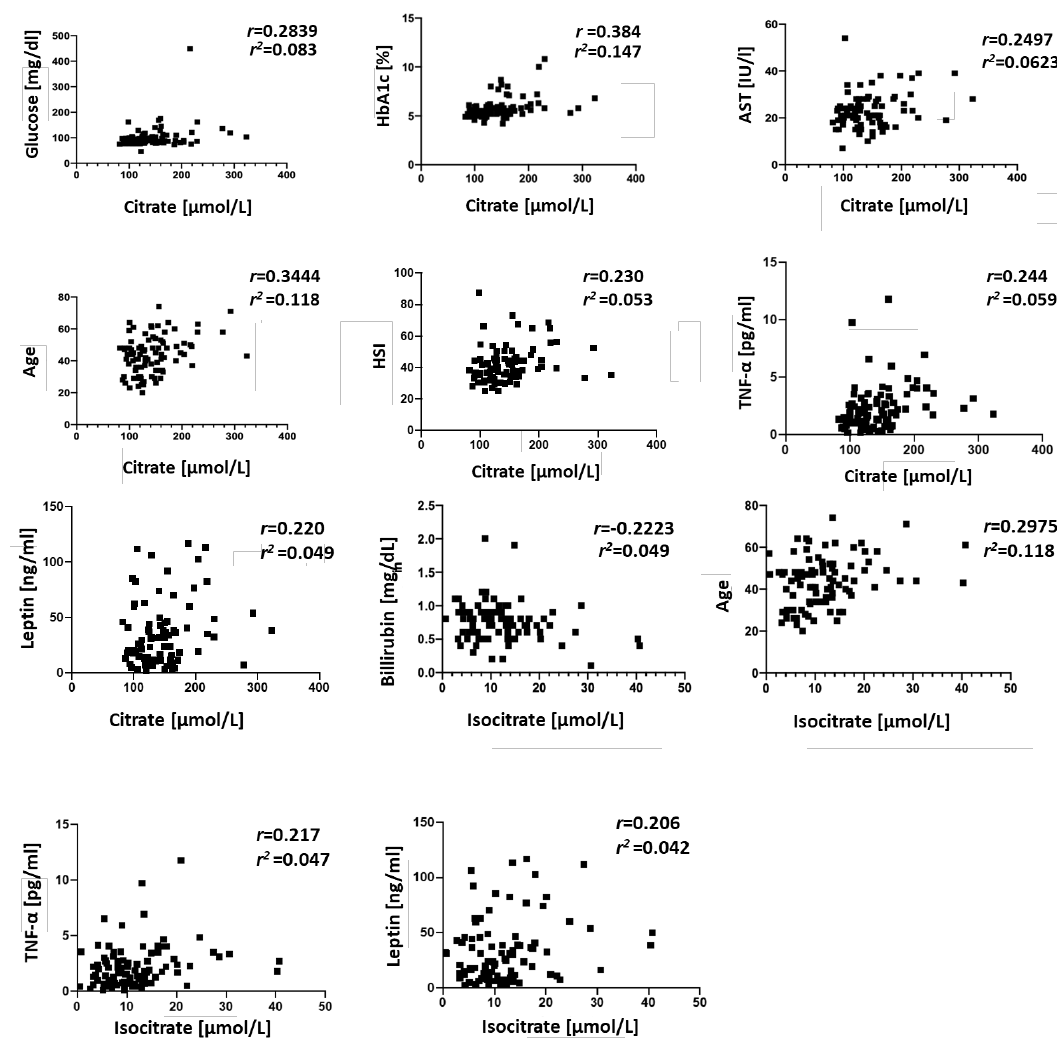
Figure 3. Significant correlations between isocitrate, citrate, age, HSI, and standard blood parameters for the entire cohort under the study. The strength of association between variables was calculated by Pearson’s test performed by Prism 8 (GraphPad). NAFLD ( n = 22) and controls ( n = 67).